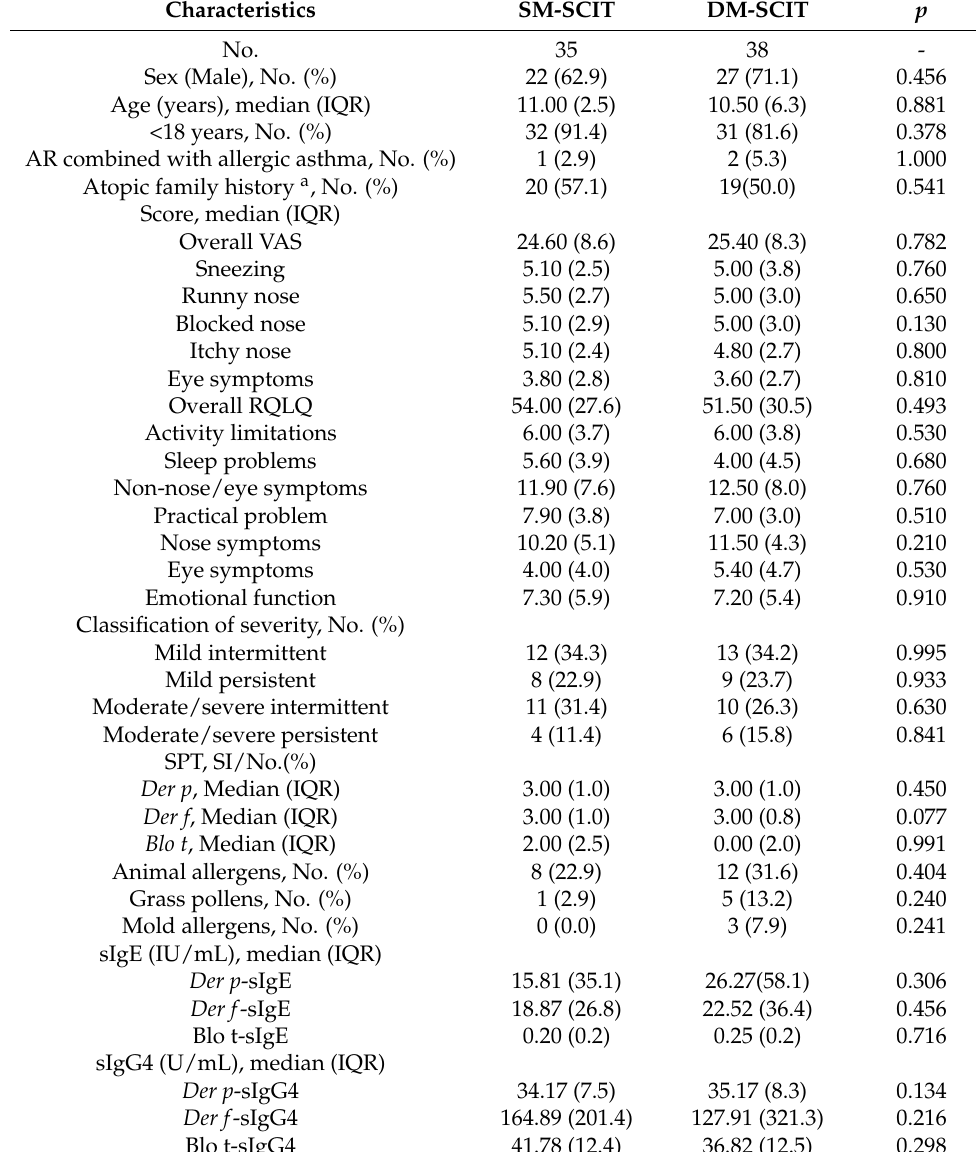
Table 1. Baseline characteristics and